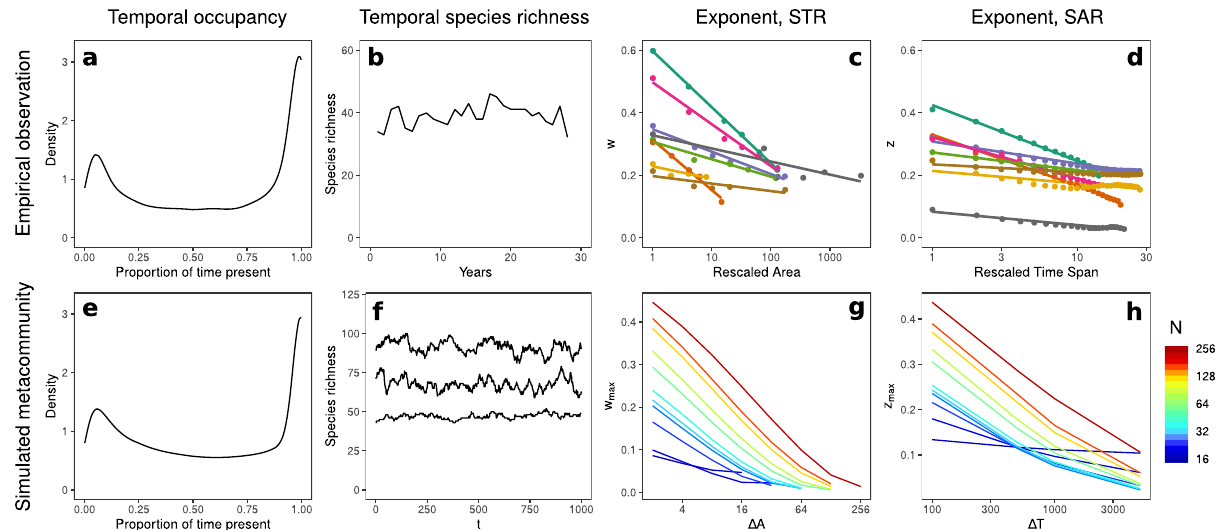
Fig. 6 Macroecological signatures of autonomous compositional change. A bimodal distribution in temporal occupancy observed in North American birds 54 ( a ) and in simulations ( e N = 64, ϕ = 5, σ 2 = 0.01, ℓ = 0.5). Intrisically regulated species richness observed in estuarine fi sh species 59 ( b ) and in simulations ( f N = 64, ϕ = 5, σ 2 = 0.01, ℓ = 0.5, 1000 unit times t ). The decreasing slopes of the STR with increasing sample area 12 ( c ), and the SAR with increasing sample duration 12 ( d ) for various communities and in simulations ( g and h N = 256, ϕ = 10, σ 2 = 0.01, ℓ = 0.5, spatial window Δ A , temporal windo Δ T ). In ( c ) and ( d ) we have rescaled the sample area/duration by the smallest/shortest reported value and coloured by community (see original study for details). In ( g ) and ( h ) we study the STAR in metacommunities of various size N , represented by colour. Limited spatio-temporal turnover in the smallest metacommunties (blue colours) greatly reduces the exponents of the STAR relative to large metacommunities (red colours). A ij = 0.5 with probability 0.5 in all